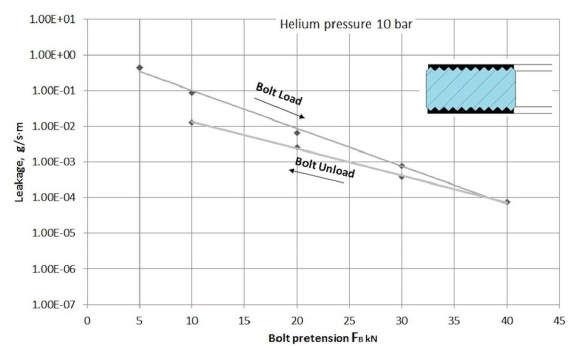
Figure 6: Leakage characteristic in load and unload state of the bolt in case of the joint gasketed with the standard gasket